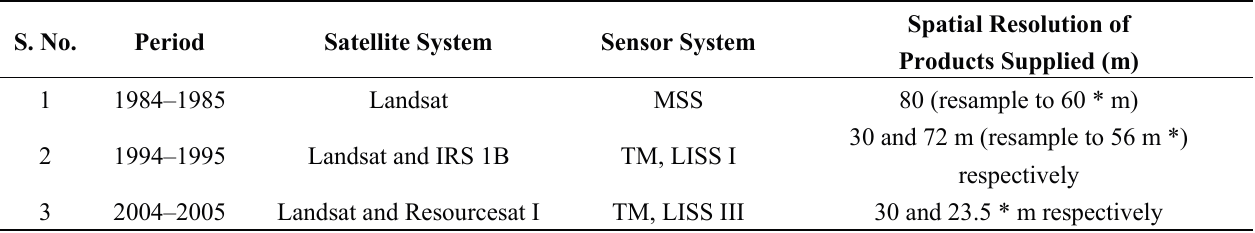
Table 4. Satellite remote sensing data used for the LULC